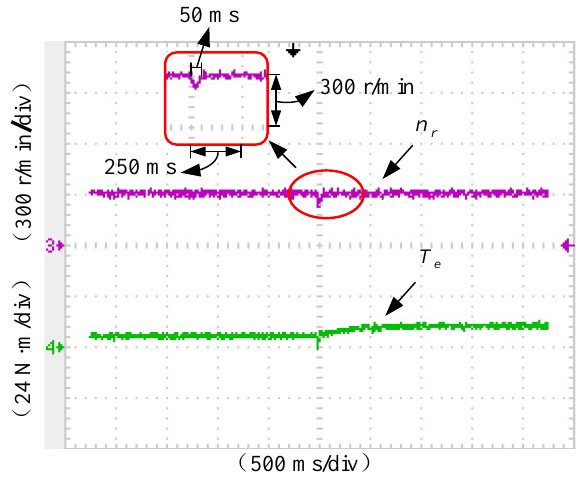
Figure 21. Dynamic performance of RDTC with TIBC (TIBC-RDTC).